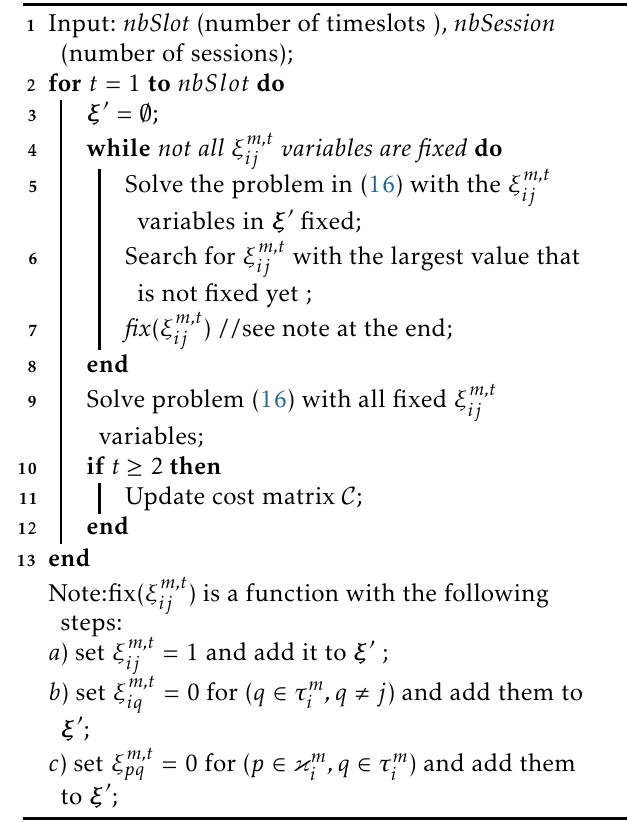
Algorithm 1: PBRS Algorithm